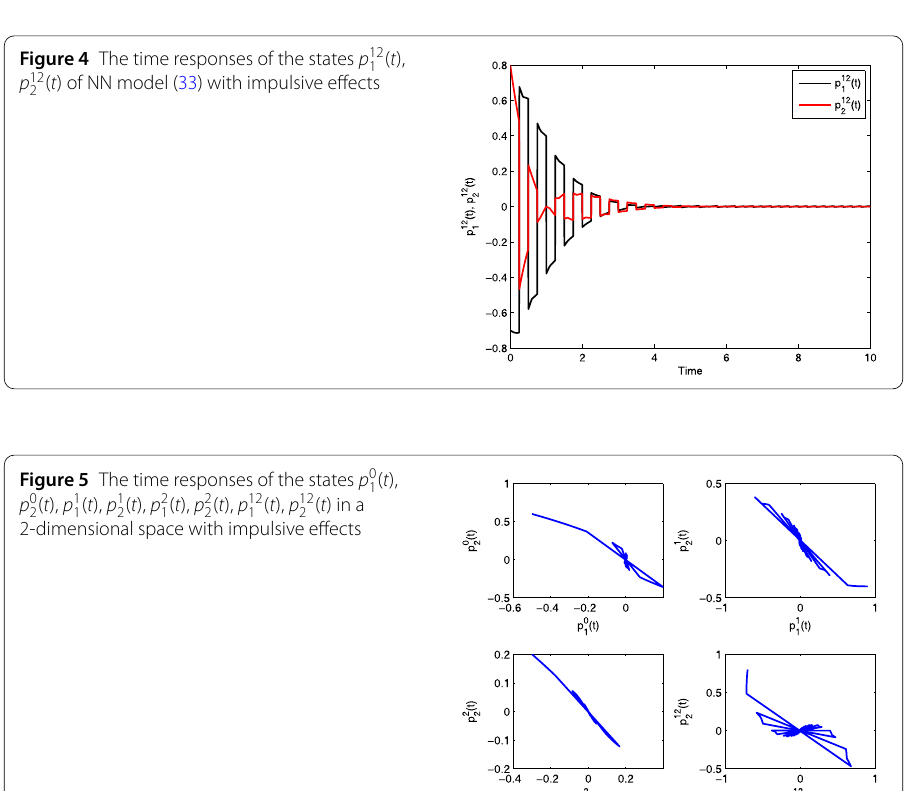
Figure 4 The time responses of the states p 12 1 ( t ), p 12 2 ( t ) of NN model (33) with impulsive effects